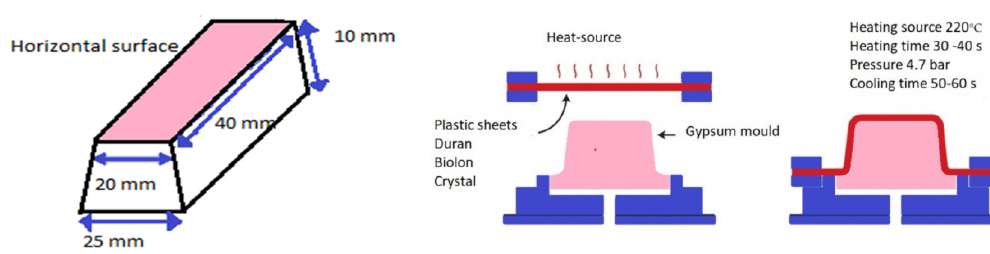
Figure 1. Fabrication of specimens to assess the color change and surface roughness, the gypsum mold, and the thermoforming process.